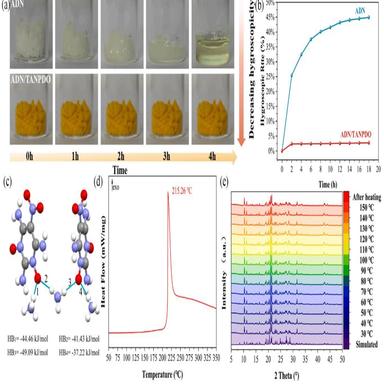
The stability of ADN/TANPDO supramolecular crystal: (a) The hygroscopic processes of the ADN (top) and ADN/TANPDO supramolecular crystal (bottom). (b) The hygroscopic rate curves for ADN and ADN/TANPDO supramolecular crystal. (c) The hydrogen bonding energy between NH4 + and TANPDO. (d) The DSC curve of ADN/ TANPDO supramolecular crystal. (e) The In situ PXRD patterns of ADN/ TANPDO supramolecular crystal.